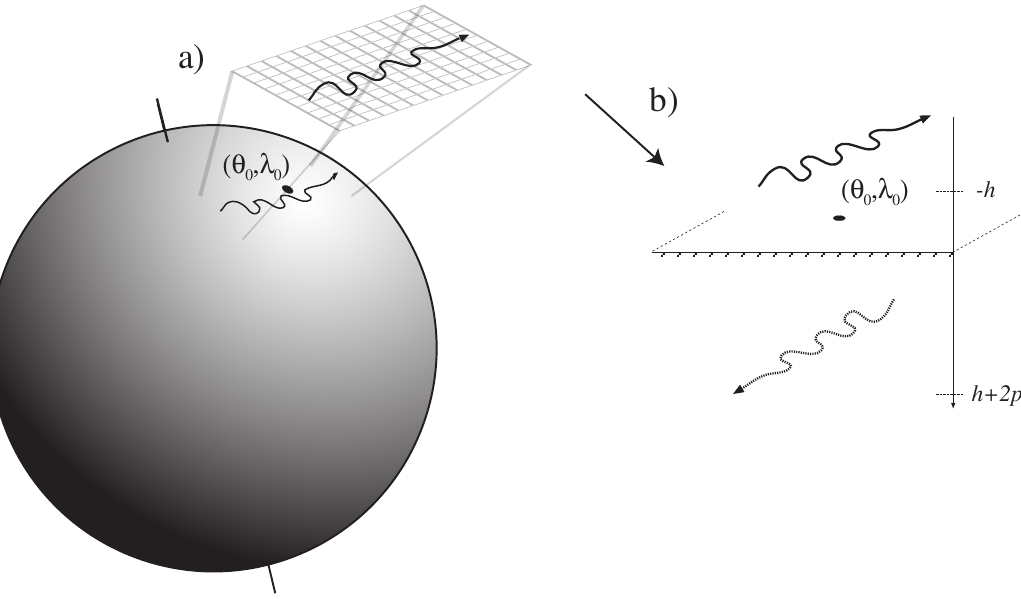
Fig. 2. Schematic view to the key steps for computing geomagnetically induced electromagnetic fields from the ionospheric output of the global MHD codes. (a) The time series of the horizontal ionospheric currents within a radius of 1000km about ( θ 0 ,λ 0 ) are transformed to Cartesian coordinates using the stereographic projection and the currents are interpolated to a uniform rectangular grid. (b) image of the original current system at the height h is placed to the depth h + 2 p . p is the complex depth determined using the 1-D conductivity structure of the Earth (Pirjola and Viljanen, 1998). The total field at ( θ 0 ,λ 0 ) is a superimposition of the fields produced by the original current at height h and the image current at depth h + 2 p